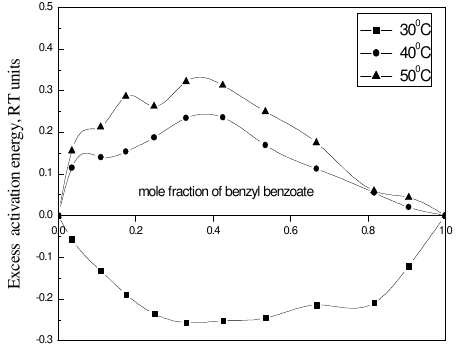
Figure 2d. Variation of excess enthalpy with mole fraction of benzyl benzoate in the mixture benzyl benzoate + benzonitrile